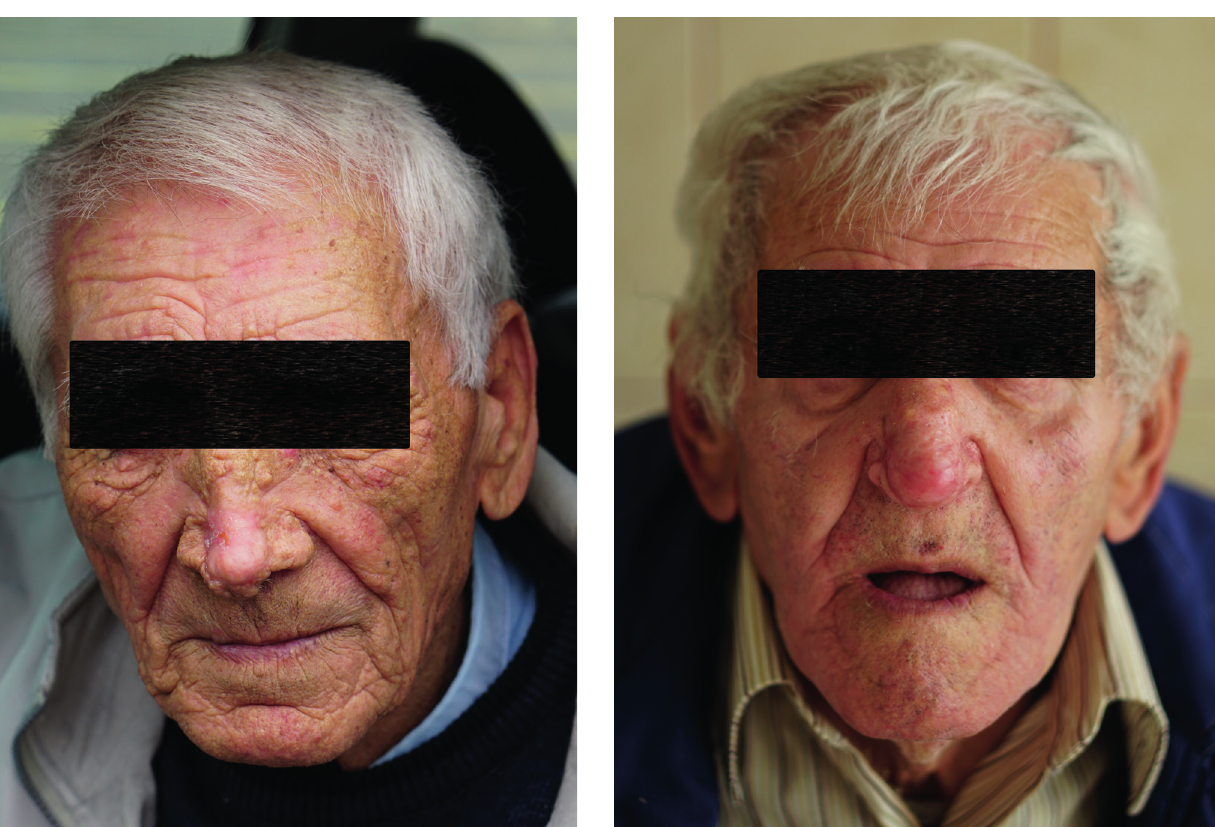
Figure 3. Patient №1 Postoperative view after one month. Figure 4. Patient №2 Postoperative view after one